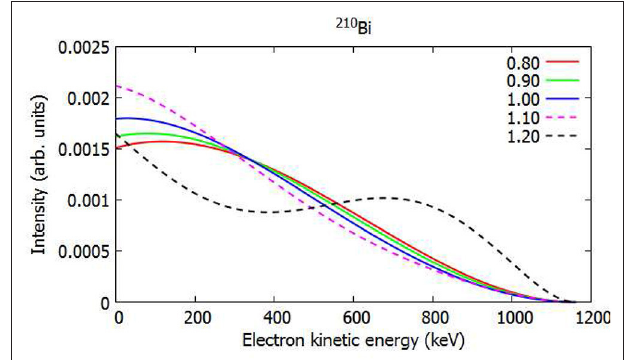
FIGURE 10 | Normalized ISM-computed electron spectrum for the first-forbidden non-unique β − decay of 210 Bi. The value g V assumed and the color coding represents the value of g A